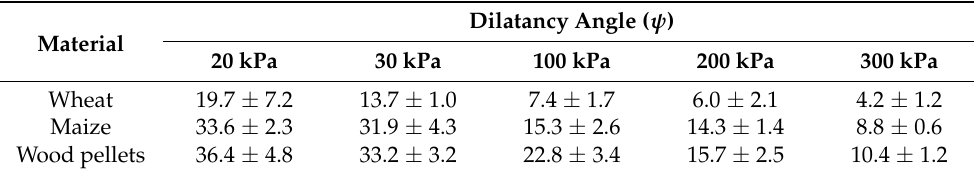
Table 2. Dilatancy angles obtained for each material under the different normal stresses assayed. Material